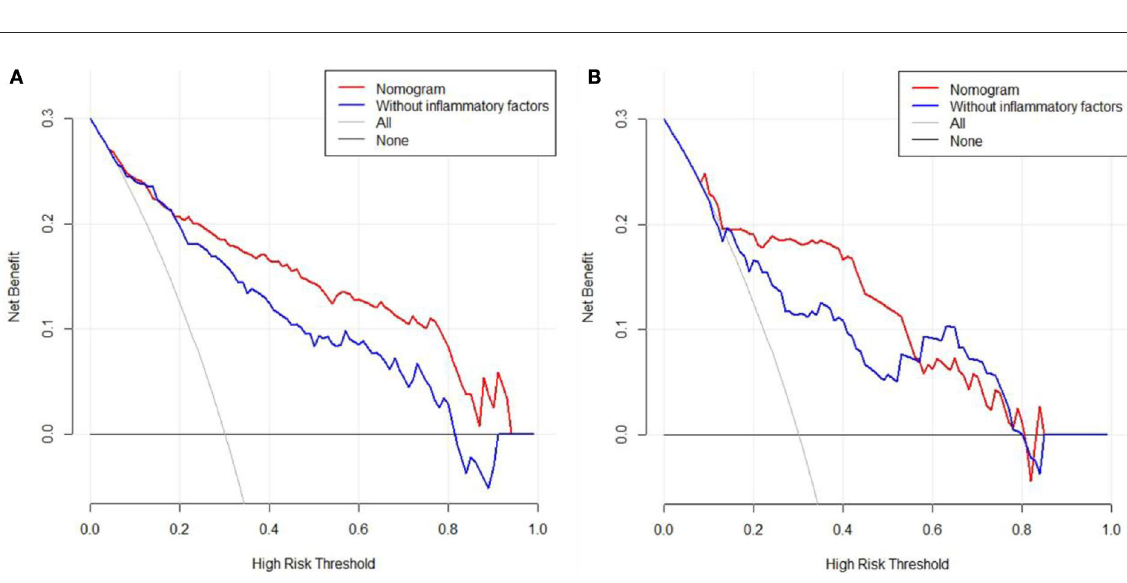
FIGURE5 Decision curve analysis for the training cohort (A) and the validation cohort (B)